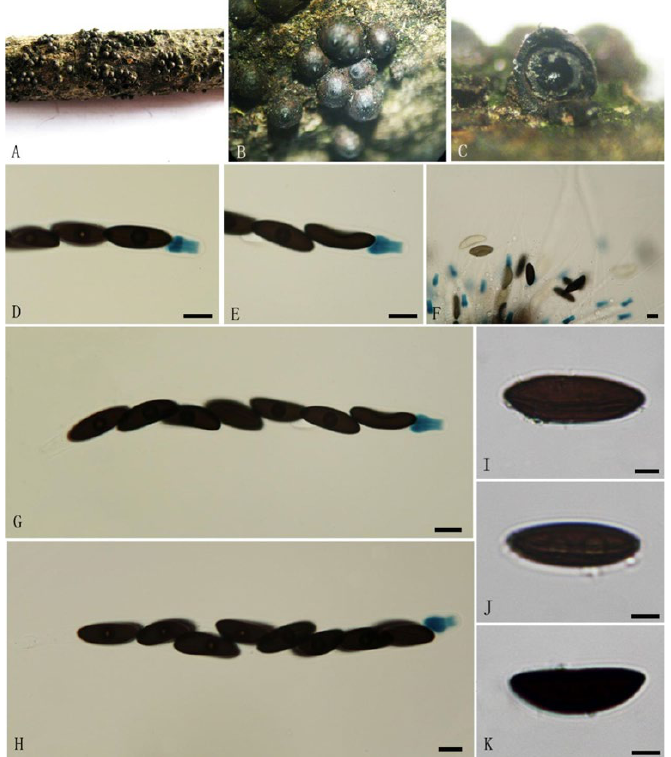
Figure 5. Rosellinia cainii (GZUH0119). ( A , B ) Stromata on the host; ( C ) Longitudinal section of stroma; ( D , E ) Urn–shaped J+ apical rings (stained in Melzer’s reagent); ( F ) Paraphyses; ( G , H ) Asci. ( I ‒ K ) Ascospores. Bars: ( A ) = 5 mm, ( B ) = 1 mm, ( C ) = 200 μm, ( D ‒ H ) = 10 μm, ( I ‒ K ) = 5 μm.